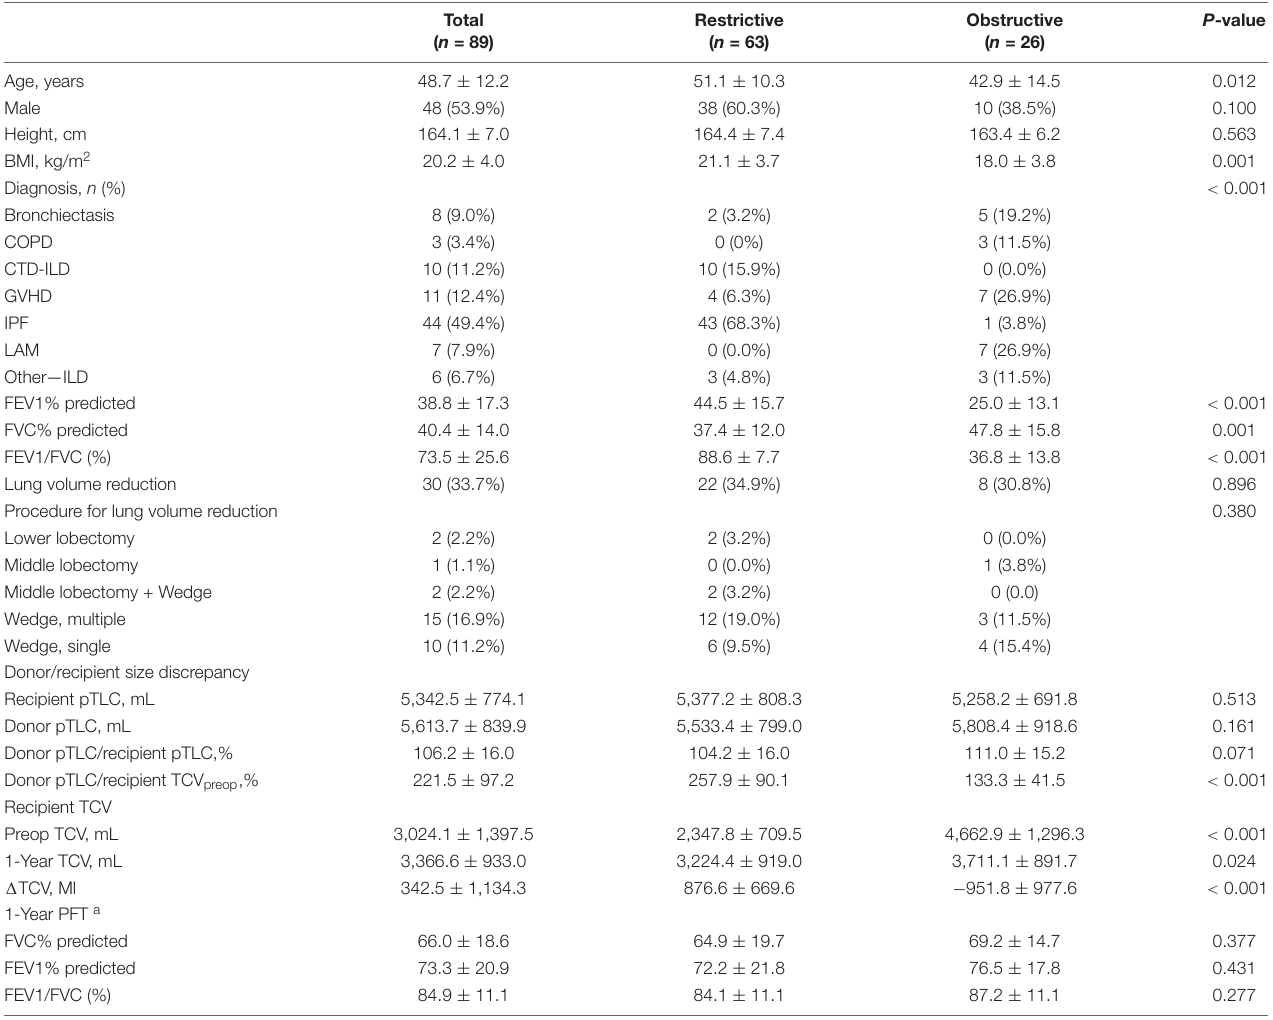
TABLE 1 | Baseline characteristics of the